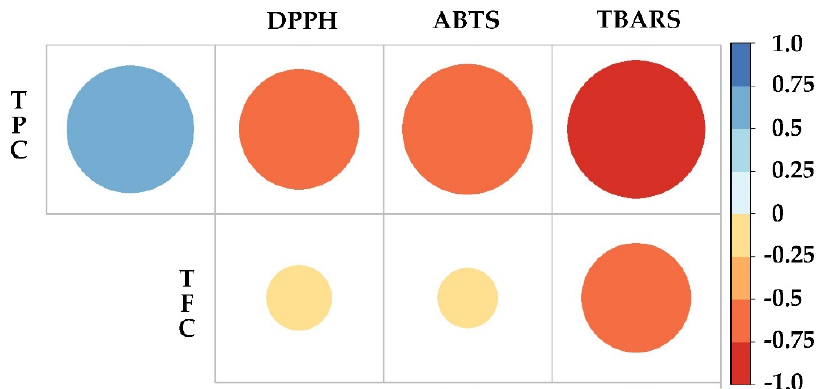
Figure 5. Pearson correlation coefficients for the antioxidant activity characterization. TPC, total phenolic compounds; TFC, total flavonoid compounds; ABTS and DPPH radical scavenging activity, TBARS inhibition of lipid peroxidation.